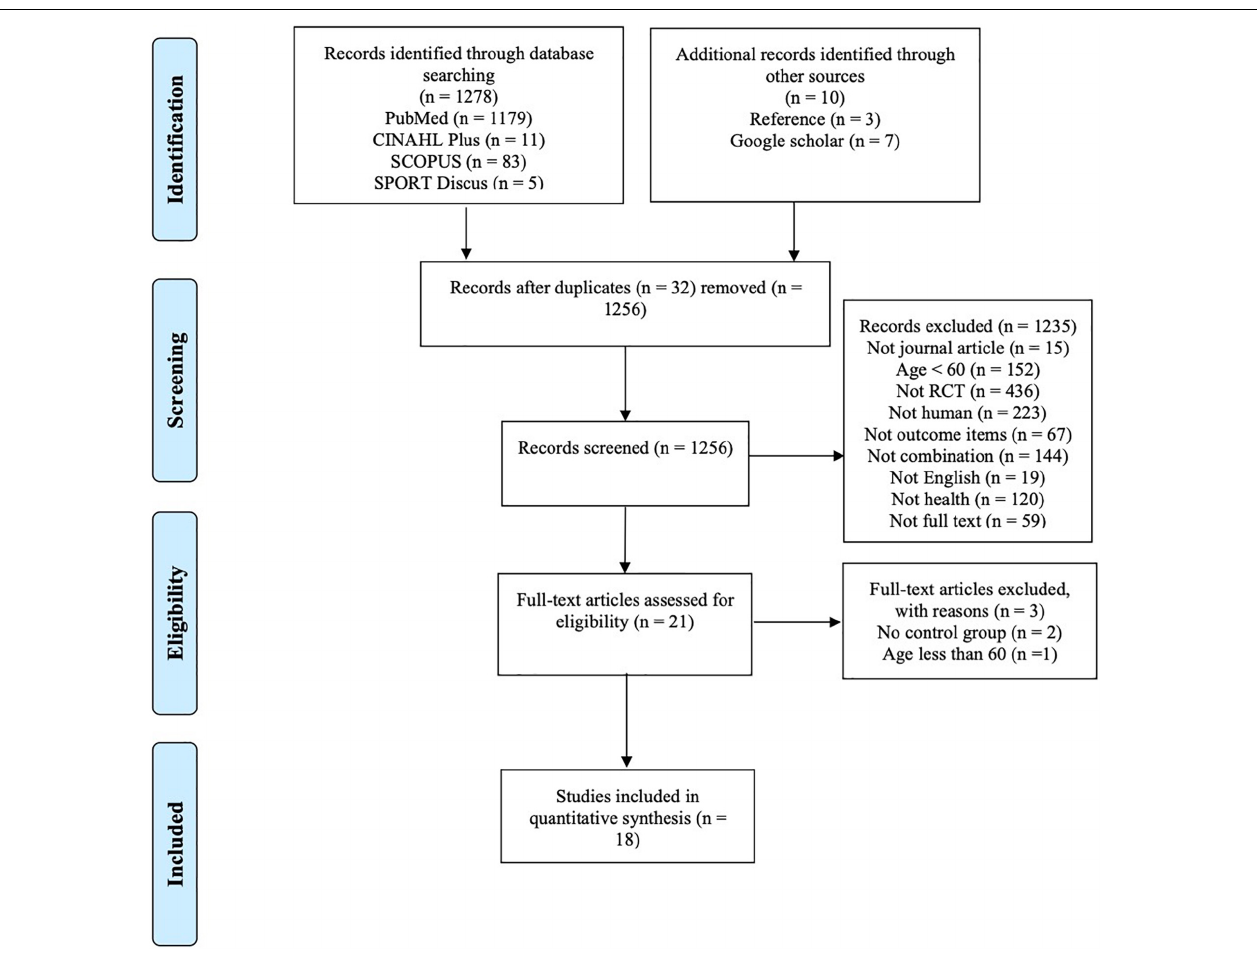
FIGURE 1 | Flow chart of study